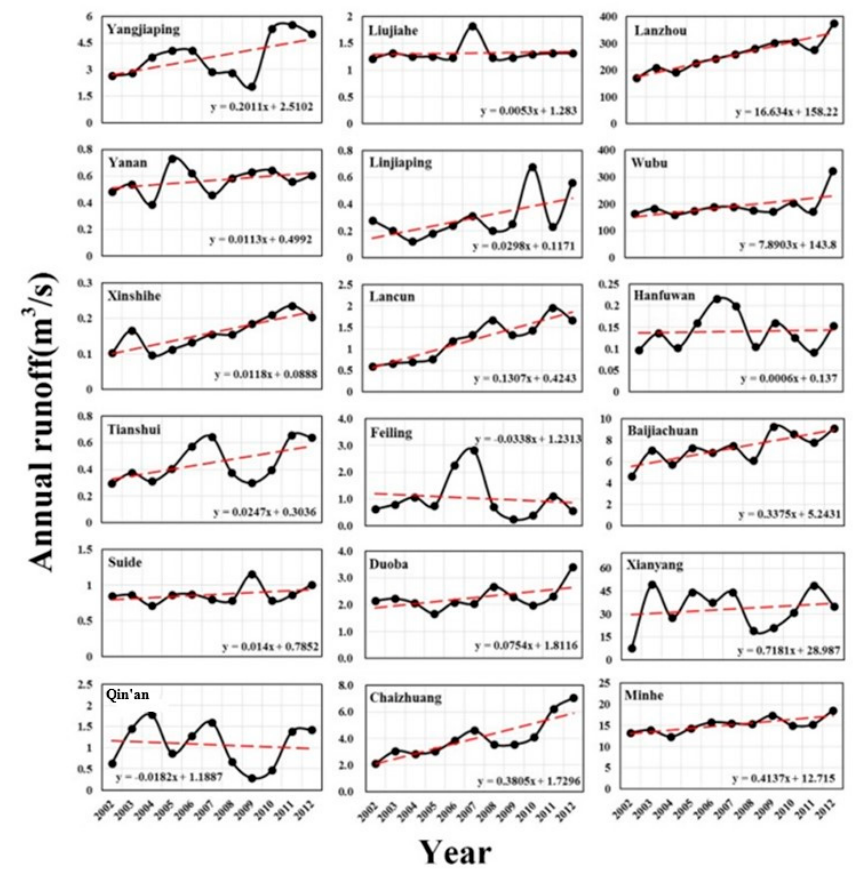
Figure 10. The temporal changing trend of runoff from 2002 to 2012 in the Loess Plateau.